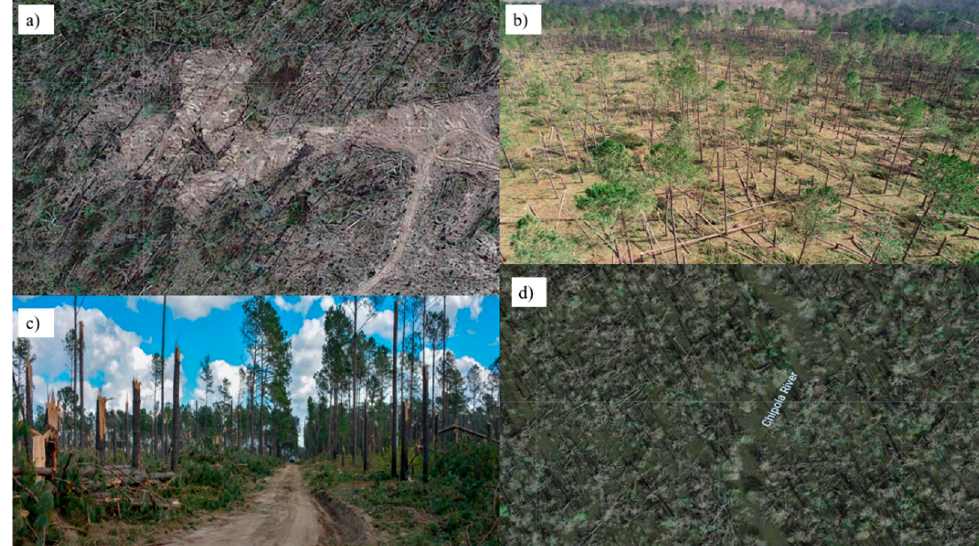
Figure 2. Aerial and ground imagery of Hurricane Michael damage to both plantation and natural forests. Salvage harvesting efforts within the Chipola River watershed ( a ), aerial ( b ) and ground ( c ) imagery of Hurricane Michael damage from the Alabama Forestry Commission Initial Damage Report [27] (reprinted/adapted with permission from the Alabama Forestry Comission. 2018, Elishia Ballentine), and ( d ) downed stems and canopy damage to riparian forests surrounding the Chipola River.